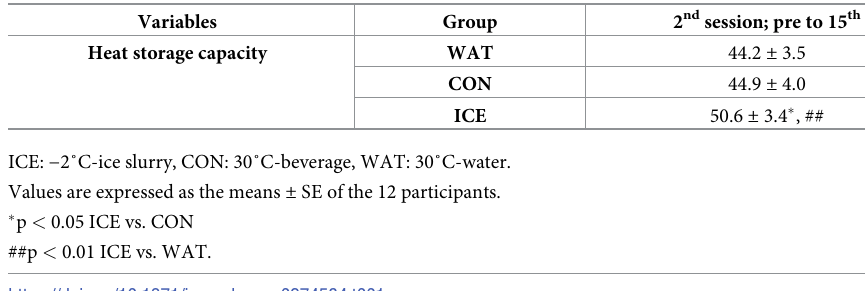
Table 1. Heat storage capacity.